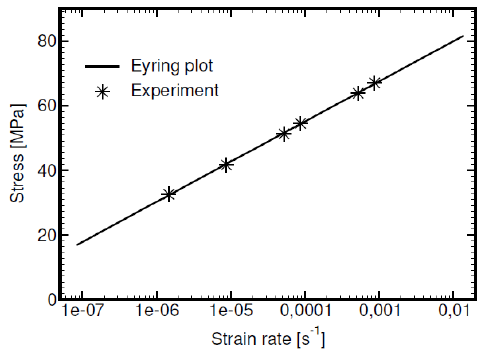
Figure 6. Approximation of master